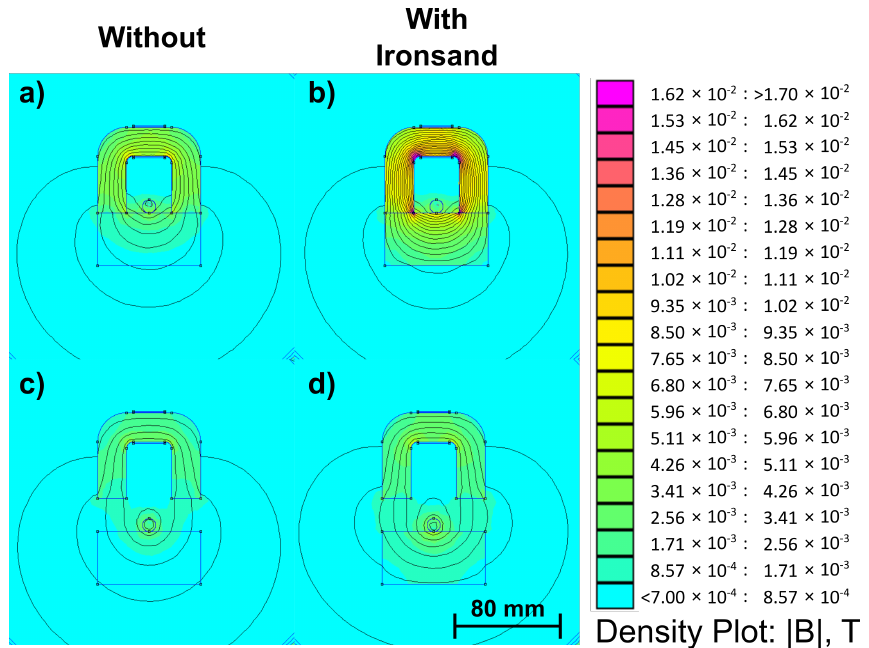
Figure 7. Changes in the magnetic field magnitude with different distances to the pick-up and the presence of ironsand: ( a ) 0 mm, no ironsand; ( b ) 25 mm, no ironsand; ( c ) 0 mm, ironsand; ( d ) 25 mm, ironsand.